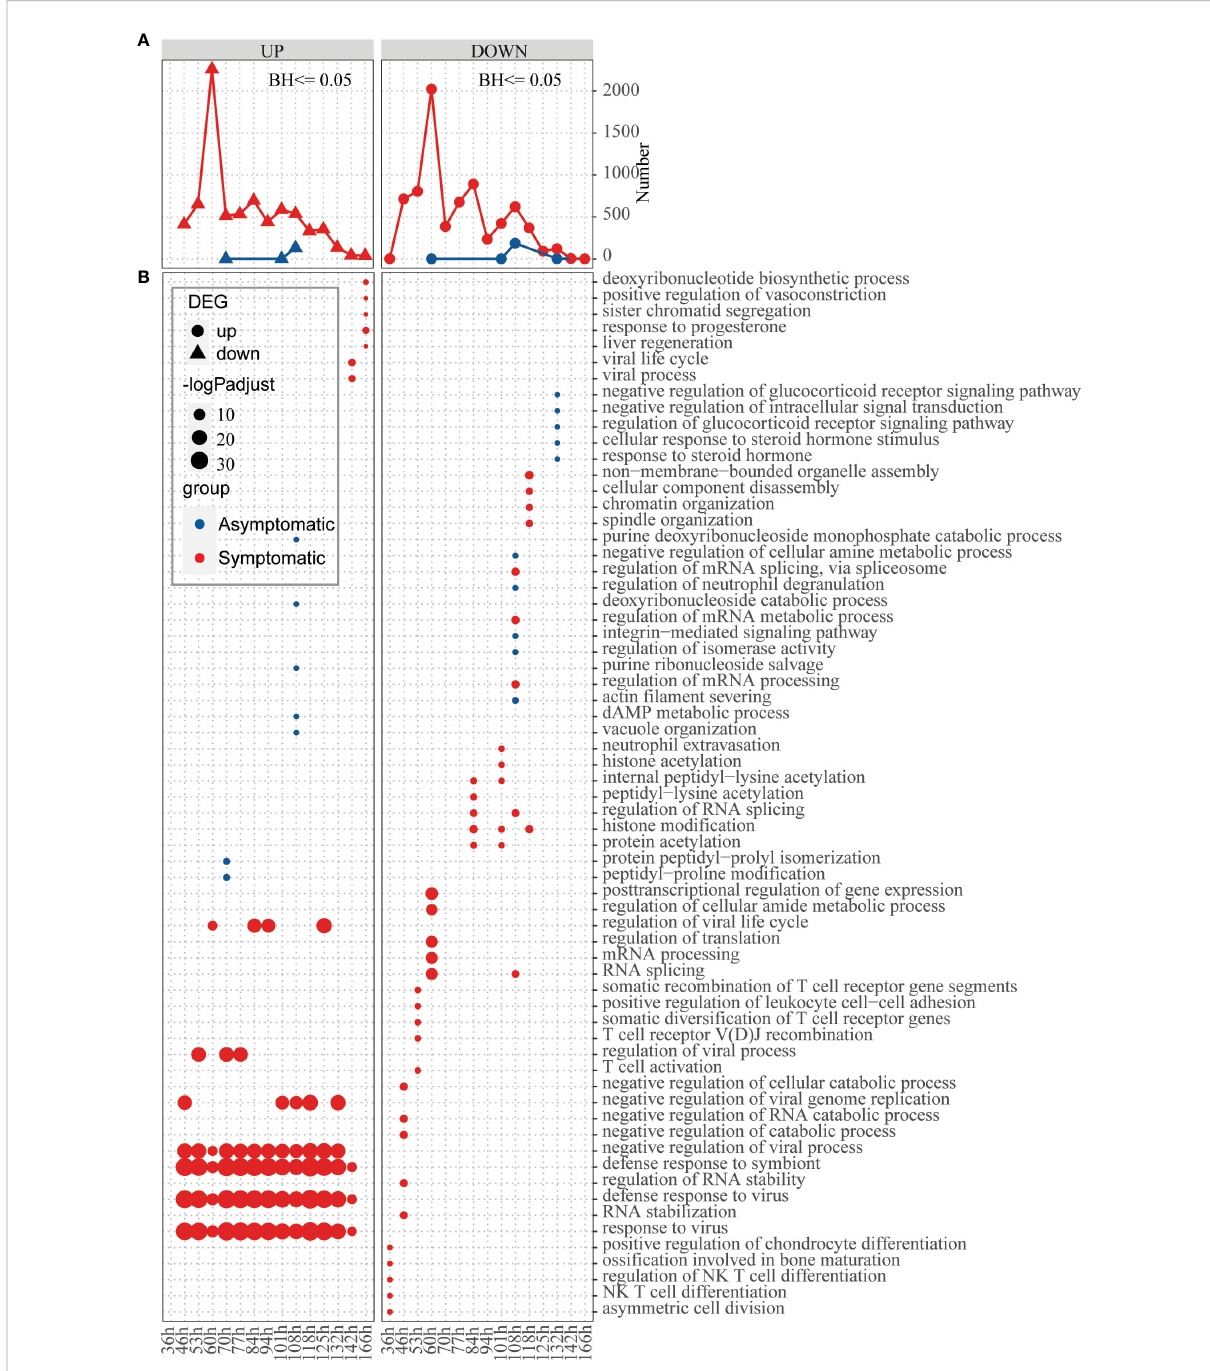
FIGURE 4 Response of hosts with different immune basis after inoculation of in fl uenza virus. (A) Line chart displaying the number of up-regulated (left) and down-regulated (right) genes in the asymptomatic (blue) and symptomatic (red) hosts at different time points, respectively. (B) Bubble chart displaying the GO biological process terms enriched for up-regulated or down-regulated genes in the asymptomatic (blue) and symptomatic (red) hosts at different time points, respectively. Dot sizes are scaled to the enrichment signi fi cance. Different colors represent different